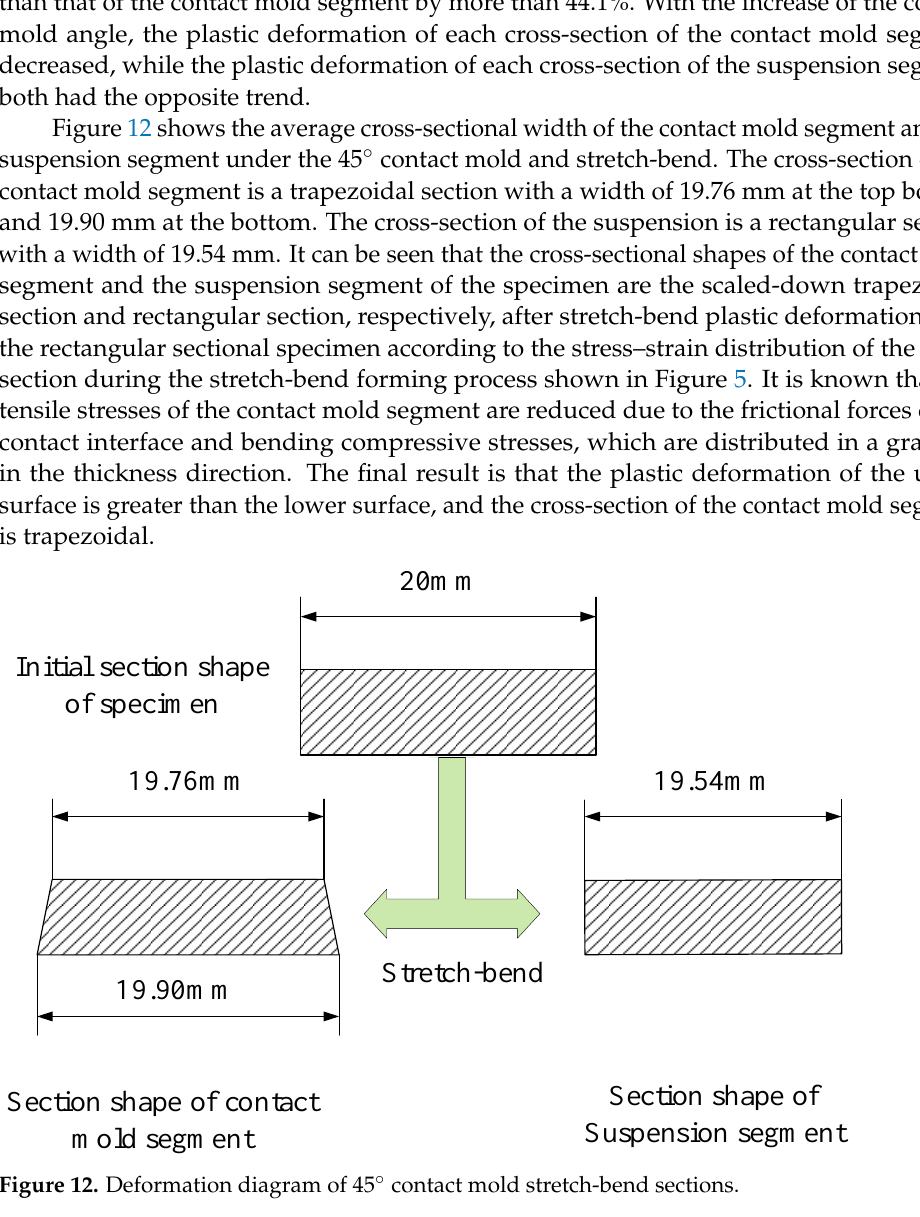
Figure 12. Deformation diagram of 45° contact mold stretch-bend sections.